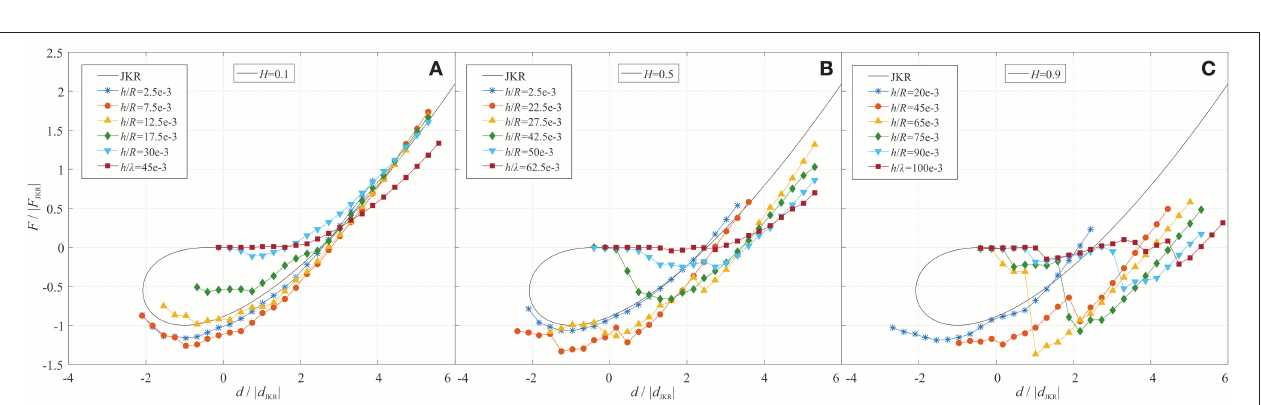
0.1; (B) H 0.5; (C) H = = =